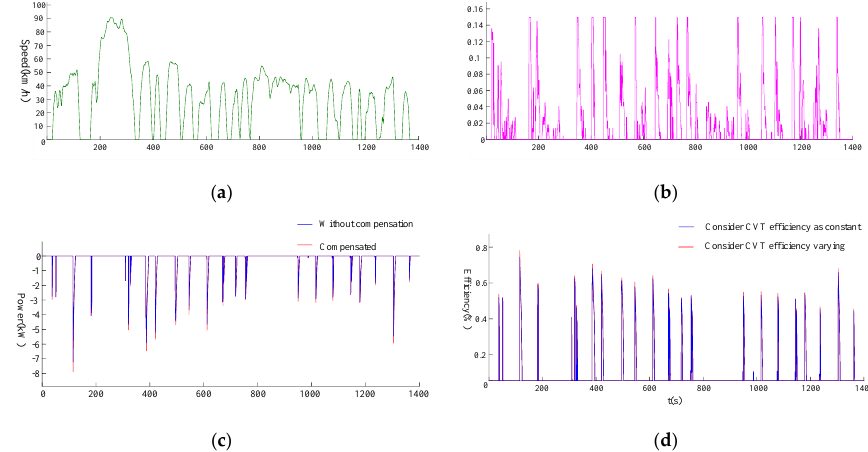
Figure 15. UDDS simulation results. ( a ) Vehicle speed; ( b ) Braking strength; ( c ) Front motor power; ( d ) Front regenerative braking system efficiency. Energies 2018 , 11 , x FOR PEER REVIEW